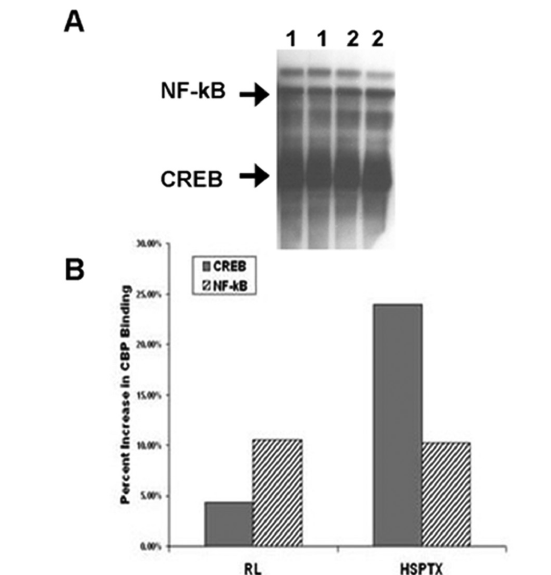
Figure 4 - Alterations in CBP Binding Activity After Resuscitation. A, Representative immunoprecipitation blot of animals resuscitated with either RL (1) or HSPTX (2). The image displays two representative animals from each experimental group. B, Graph demonstrating the percent increases in NF- κ B and CREB CBP-binding activity after resuscitation with RL or HSPTX. Treatment with RL resulted in a greater proportion of NF- κ B co- activation, while CBP-CREB binding activity was shown to predominate with HSPTX treatment. The graph presents changes in mean pixel density for n = 5-7 animals per